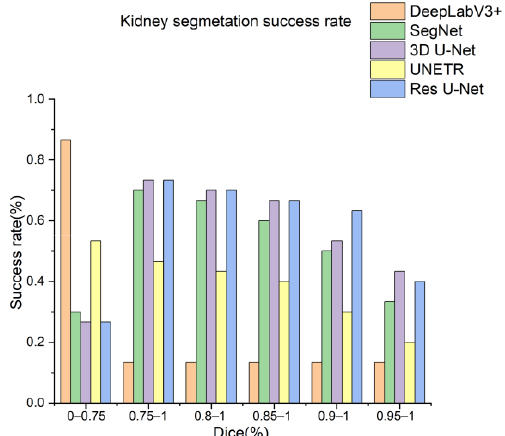
Figure 11. Kidney segmentation success rate of segmentation networks trained independently.